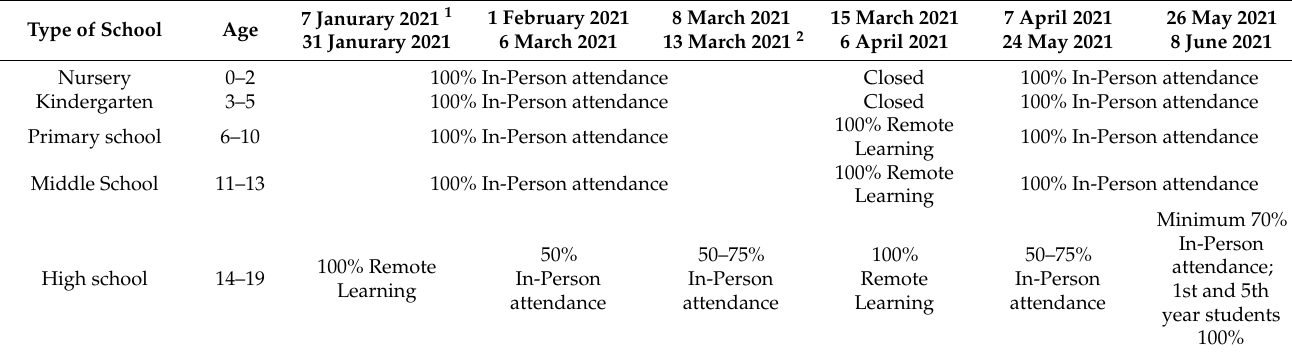
Table 1. School Calendar in the Veneto